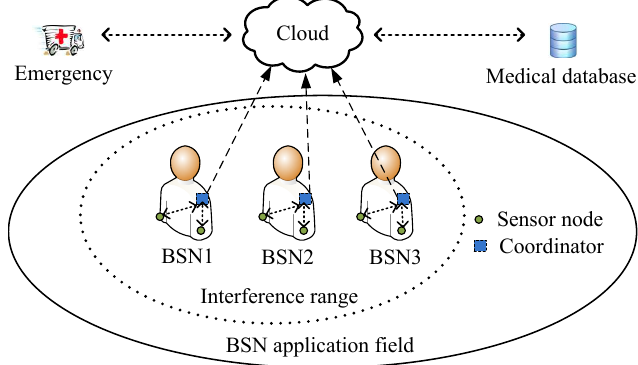
Figure 1. The common architecture of body sensor networks